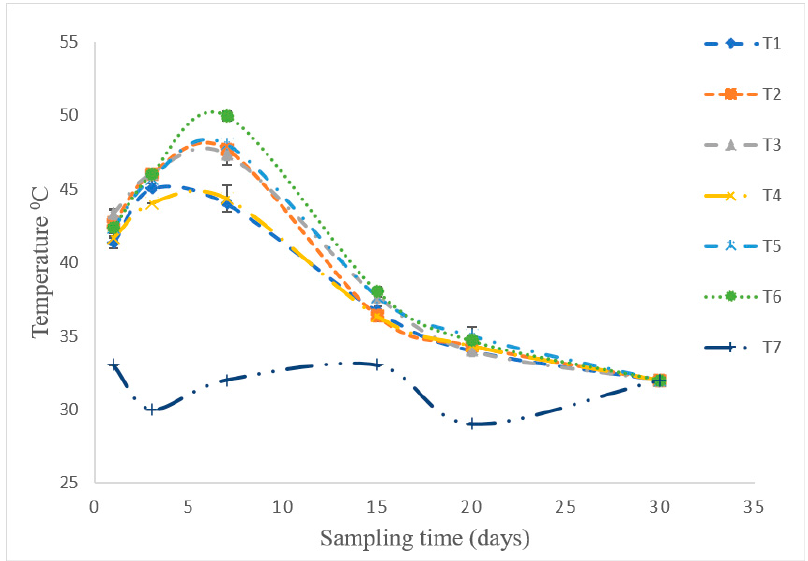
Figure 1. Ambient and composts temperature during co-composting of FVW and BMW at di ff erent ratios (3:1, 1:2 and 1:4). key T1: compost 3:1 − IMO, T2 compost 1:2 − IMO T3 compost 1:4 −